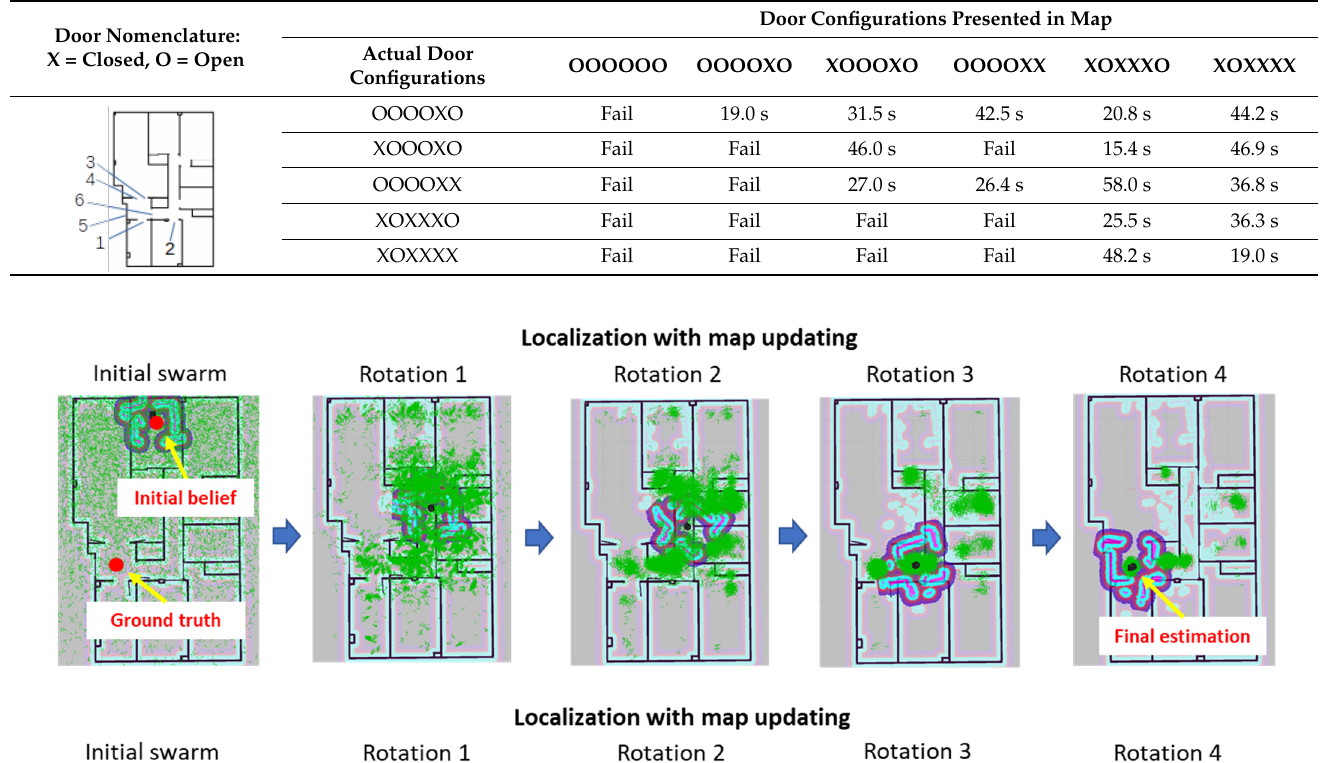
Table 3. Results of the kidnapped robot in station 1 with different door configurations.